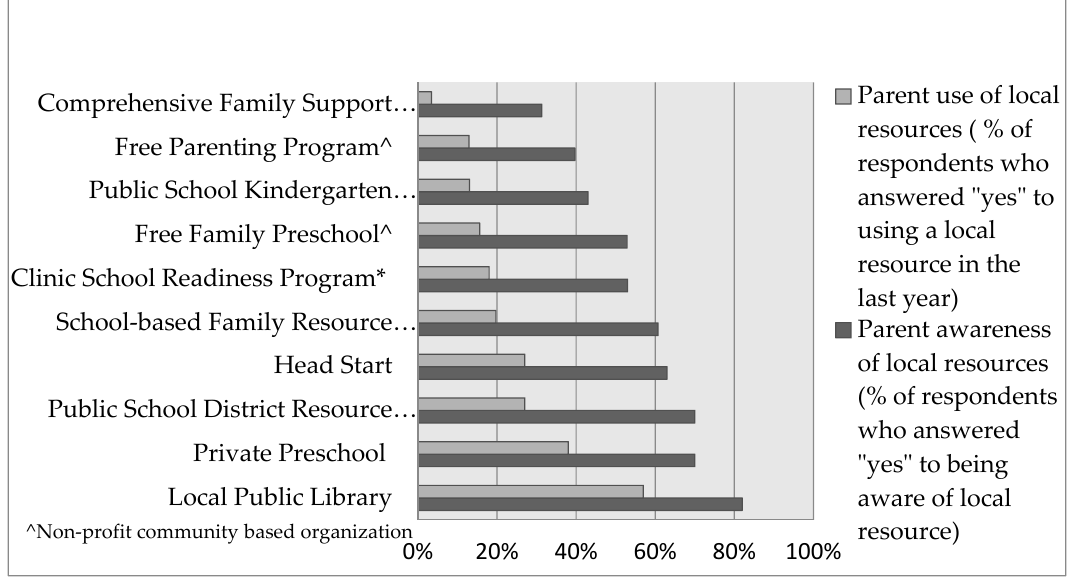
Figure 1. Parent awareness and use of local school readiness services in the last year (n = 210). * A unique service offered by c linic.